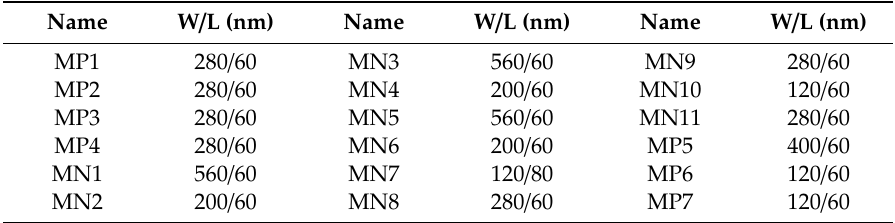
Table 1. Transistor sizes of the proposed